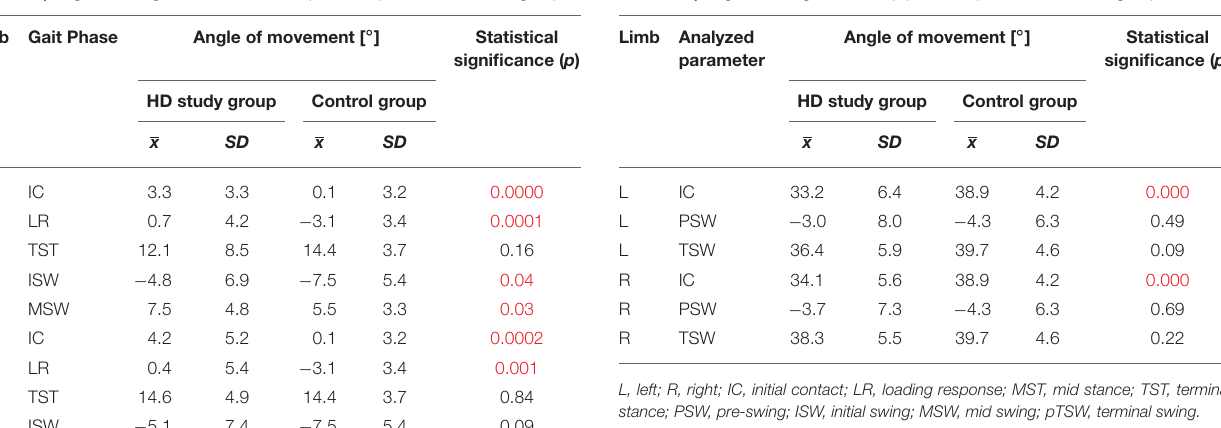
TABLE 5 | Angular changes in the hip joint compared with control group. Limb Analyzed Angle of movement [ ◦ ] significance ( p ) parameter